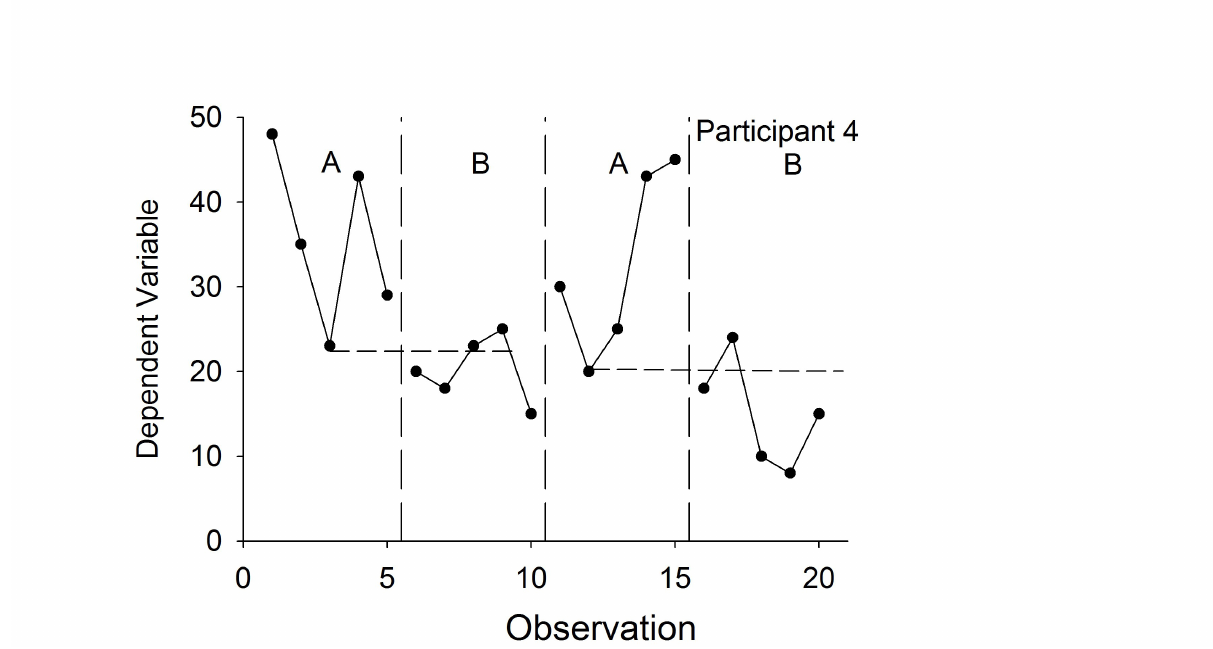
Figure 3. A visual example of how to calculate the percentage of nonoverlapping data (see text for